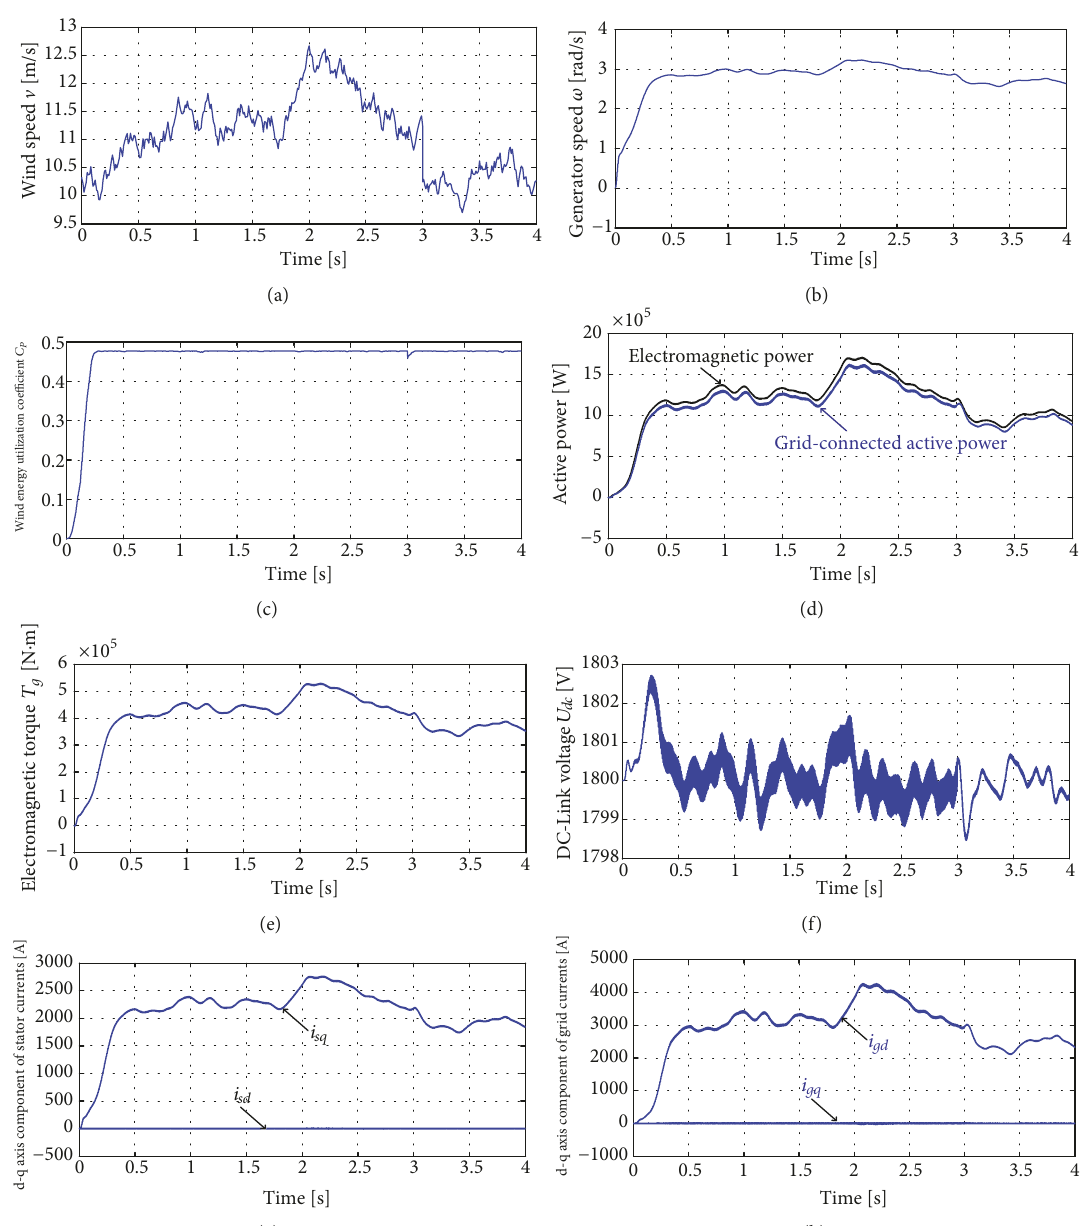
Figure 9: Variable wind speed and system